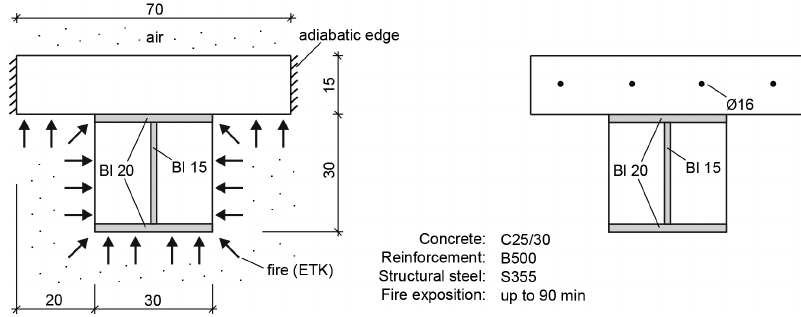
Fig. 5. Cross section properties for the thermal (left) and the mechanical (right) analysis